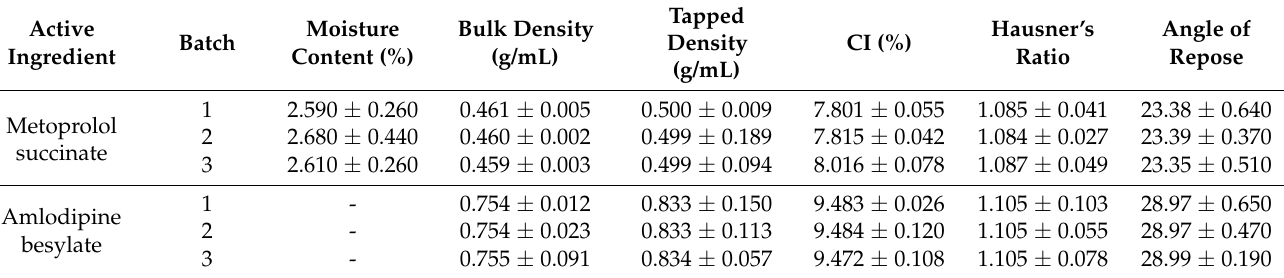
Table 7. Evaluation parameters of